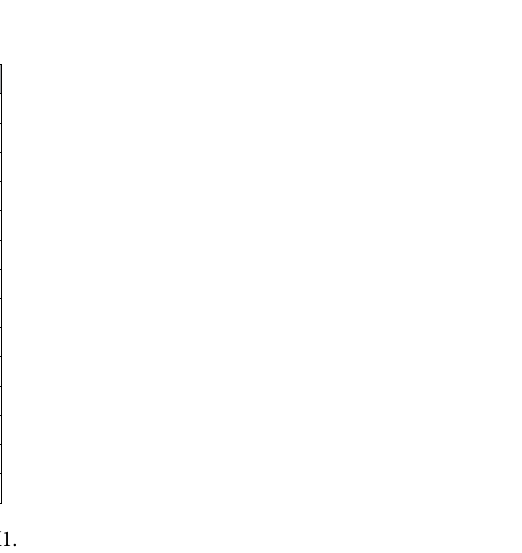
Table 2. Genome statistics based on substrain